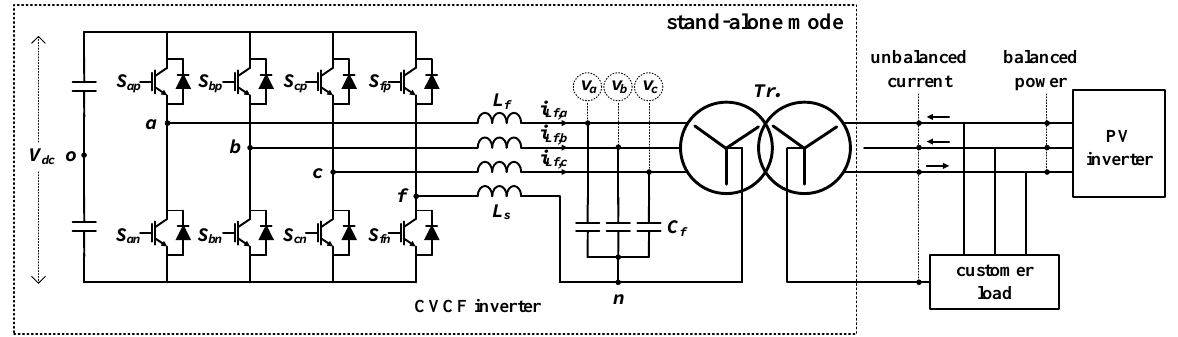
Figure 8. Operation condition of stand-alone mode.